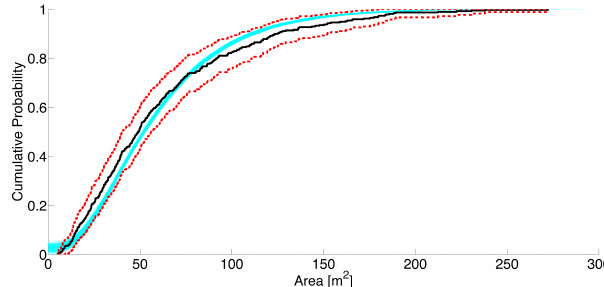
Fig. 4. Cumulative probability distribution of polygon center sizes. Observations (blue line), and 100 model realizations (cyan lines) are compared. The figure displays area on the x axis. Mean size of center area is 61 . 19m 2 in the observations and 61 . 36m 2 in the model on. These values are comparable as confirmed by a Student’s t test. Distribution and standard deviation of data and model output are also comparable. Red lines represent the confidence bounds for the data cumulative distribution function at a 0.01 confidence